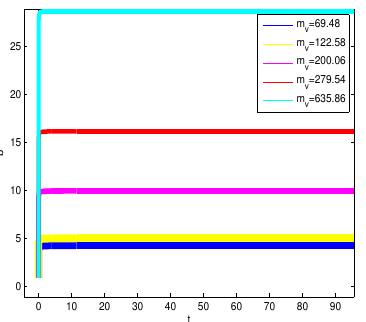
Figure 4. Local view of effects of m v on beetles in Figure